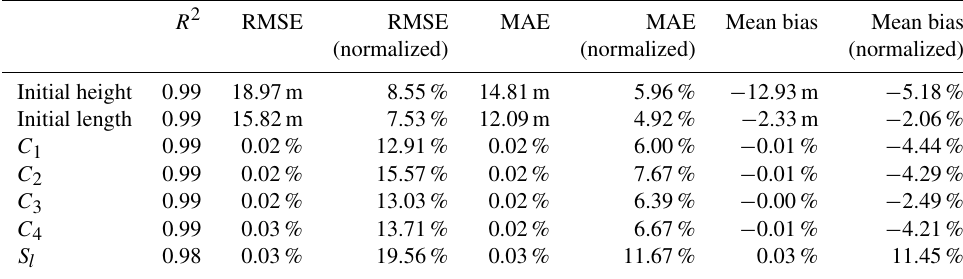
Table 1. Errors and bias of the predicted parameters. Prediction errors are exhibited by the root mean squared error (RMSE) and the mean absolute error (MAE), and the mean bias is also described. Normalized values of RMSE, MAE, and mean bias by true values are also shown. R 2 RMSE RMSE